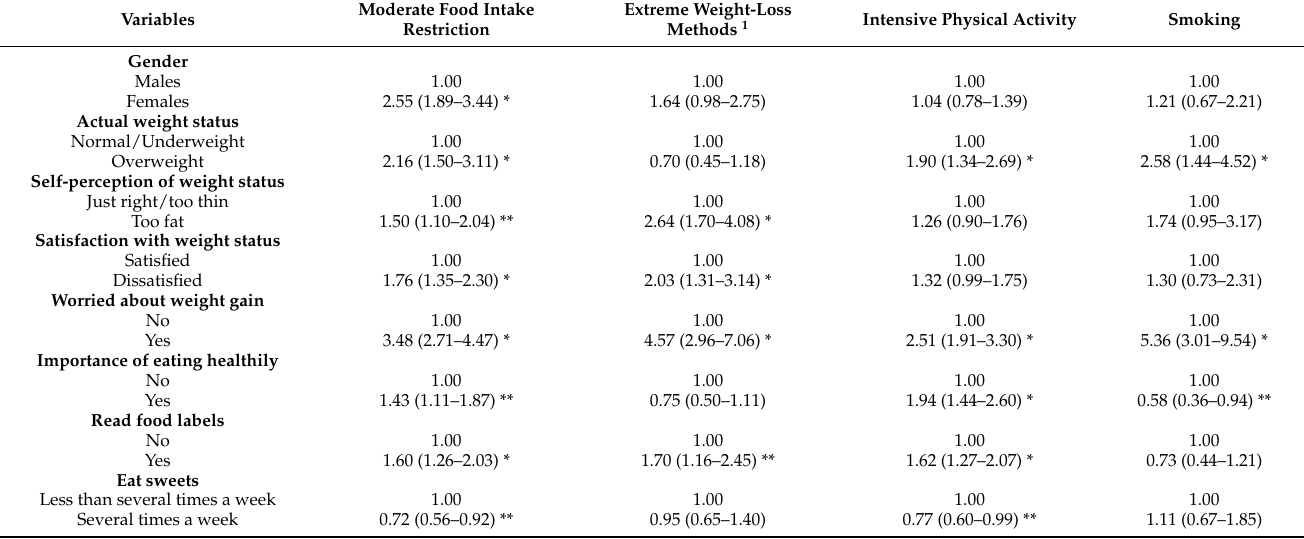
Table 7. Association of weight-management practices with body weight status, weight perception and attitude to body weight and healthy